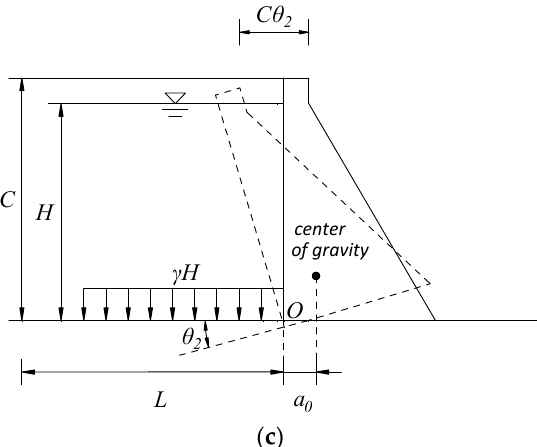
Figure 1. Schematic of the influence of hydraulic load on horizontal dam displacement: ( a ) horizontal displacement of dam foundation; ( b ) horizontal displacement caused by rotation of the dam foundation; and ( c ) horizontal displacement caused by dam rotation and shear horizontal movement. (unit: m).